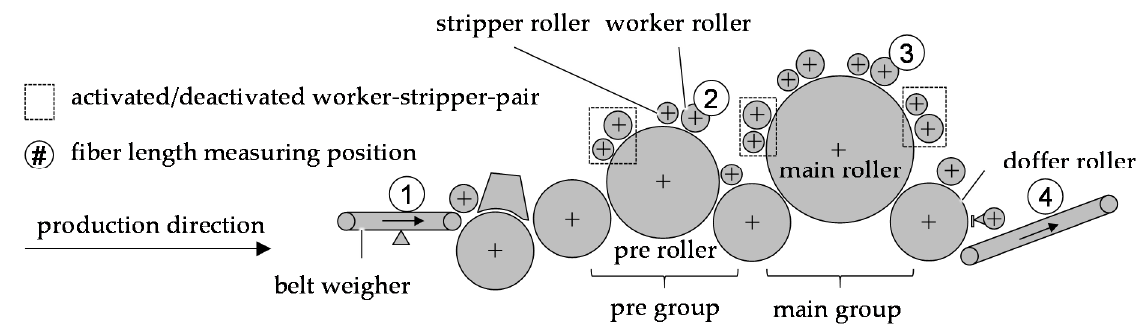
Figure 2. Schematic representation of the carding machine. The numbers indicate the positions of sampling for the fiber length measurements [30].